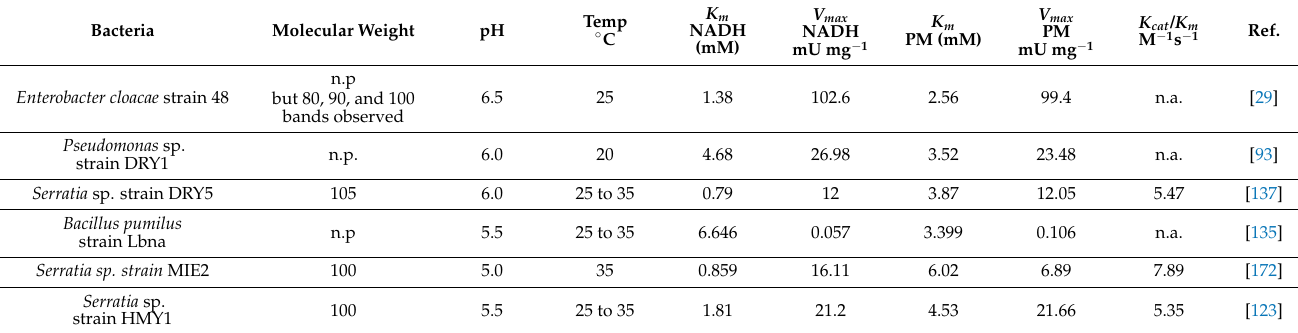
Table 4. Characteristic of the partially purified molybdenum-reducing enzyme from other bacterial sources.